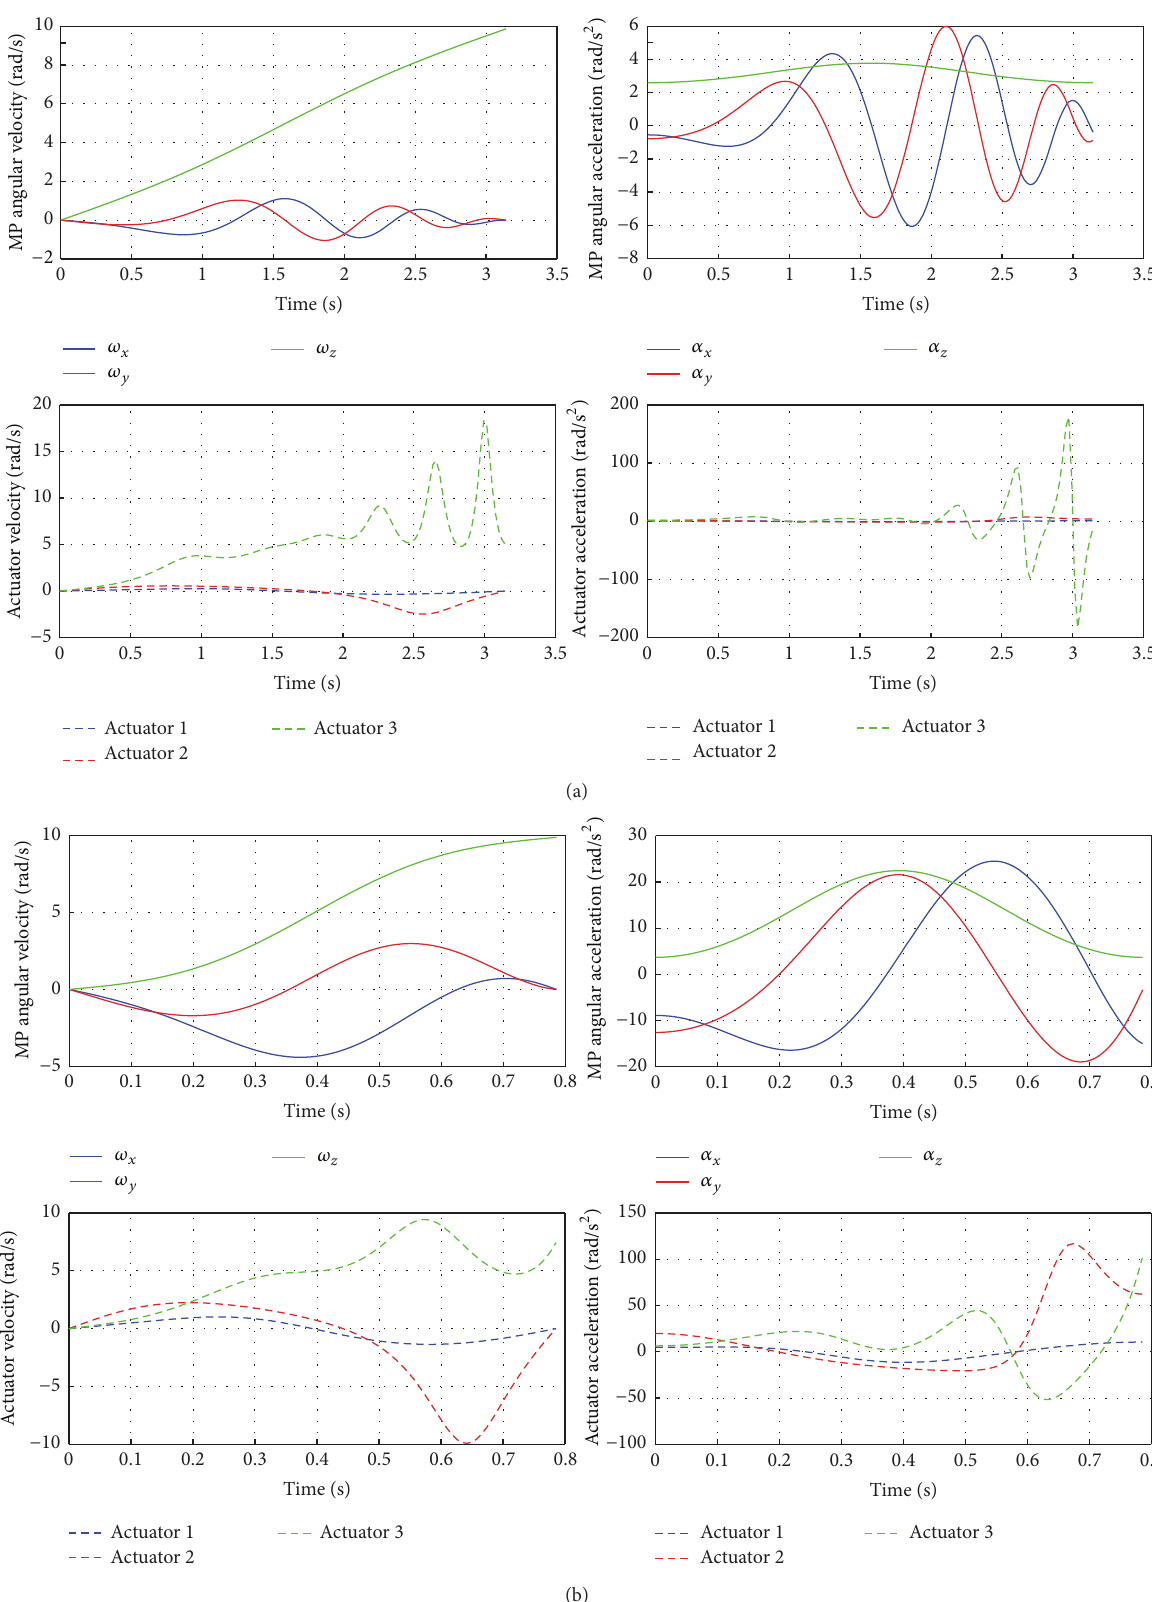
Figure 7: The velocity and acceleration profiles for the simulations: (a) trajectory 1; (b) trajectory